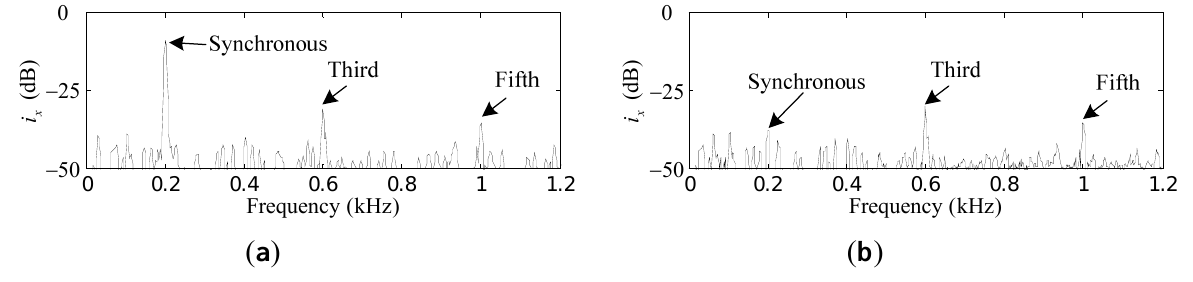
Figure 17. Experiment results of i x : ( a ) before synchronous current reduction; ( b ) after synchronous current reduction.